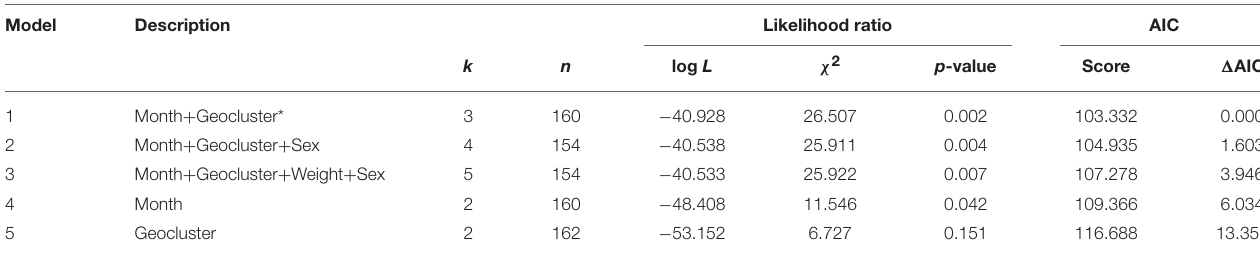
TABLE 2 | Best-fitting models explaining influenza A virus status of urban rats.